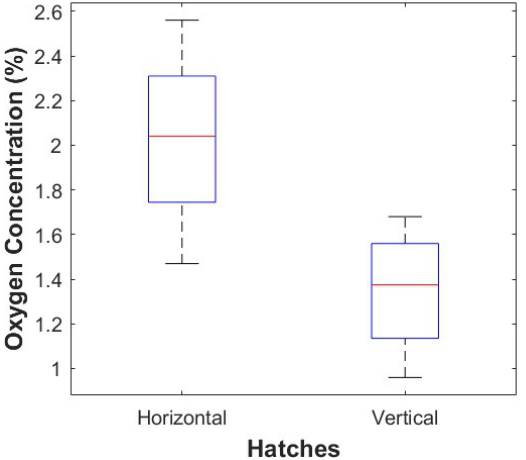
Figure 10. Boxplot diamgram of the oxygen concentrations from the SEM measurements on four regions on the axis of the horizontal and vertical hatches.